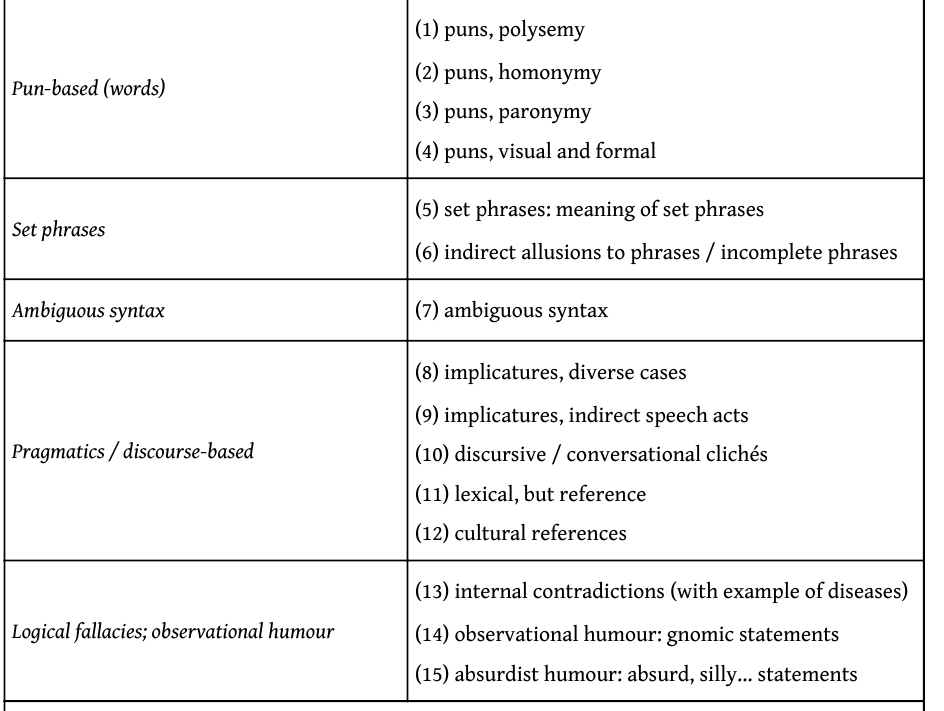
Table 1. A summary of the types of one-liners presented in section 1 in relation to the main devices used